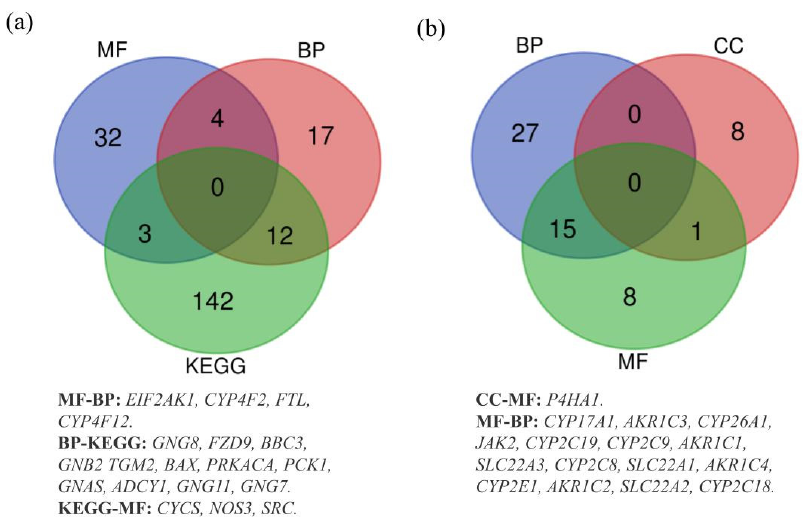
Figure 2. ( a ) Overlapping gained genes in KEGG, BP and MF datasets. ( b ) Overlapping lost genes in BP, CC and MF datasets.